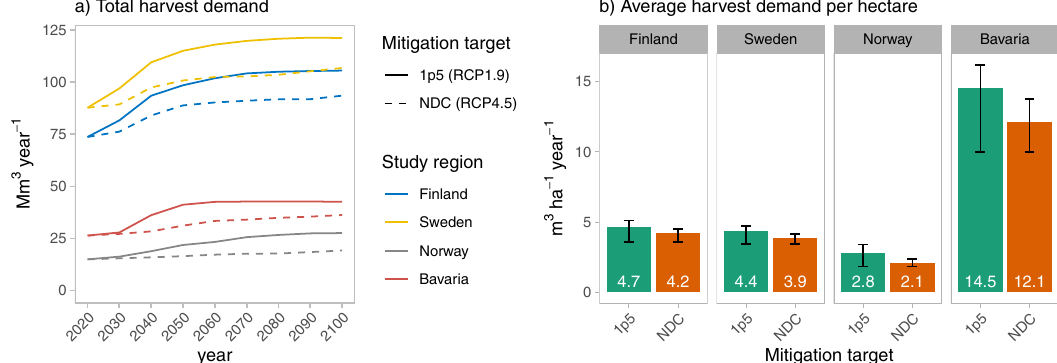
Fig. 2 Expected future harvest demands representing EU policy targets for climate change mitigation. Scenario 1.5°C (1p5) is following the representative concentration pathways RCP1.9, and scenario Nationally Determined Contribution (NDC) is following RCP4.5. a shows the total demands over time by study region, and b the corresponding average demands per hectare with error bars representing the minimum and maximum value over time (strictly protected areas without management were excluded from per hectare